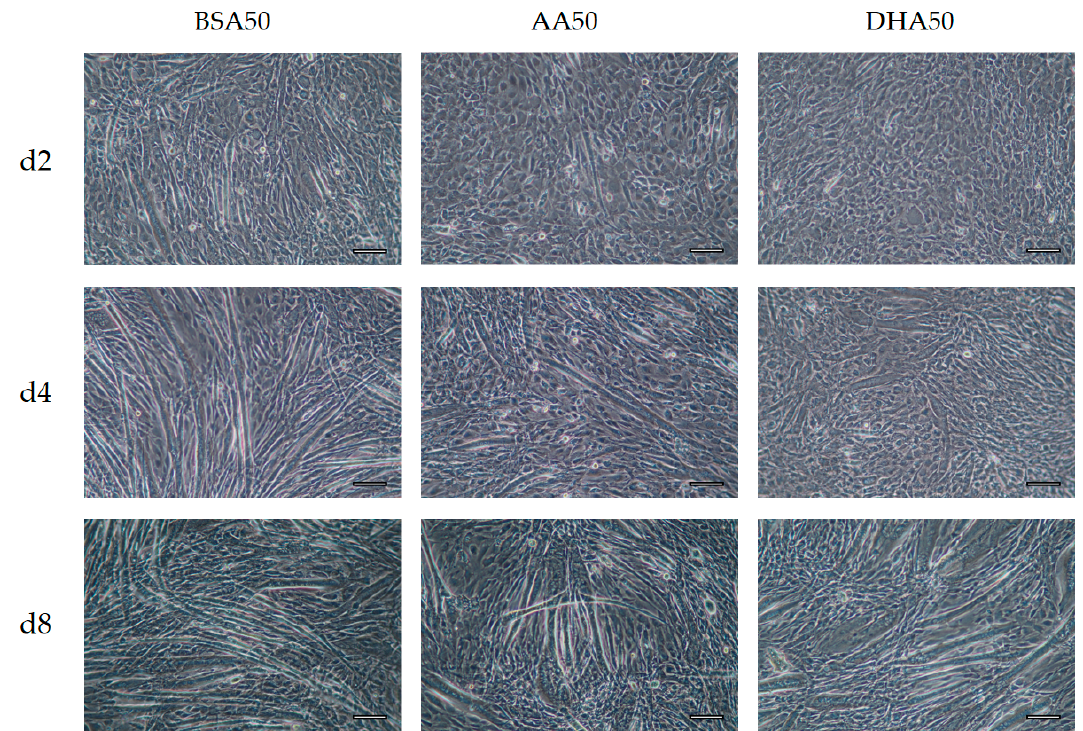
Figure 5. The phase contrast images of C2C12 differentiation stages under different treatments at different time points (Day 2 (d2), Day 4 (d4) and Day 8 (d8)). BSA20, AA20 and DHA20 treatments were added only on the first 2 days and then switched with normal DM medium till day 8. Scale bar 100 μ m.